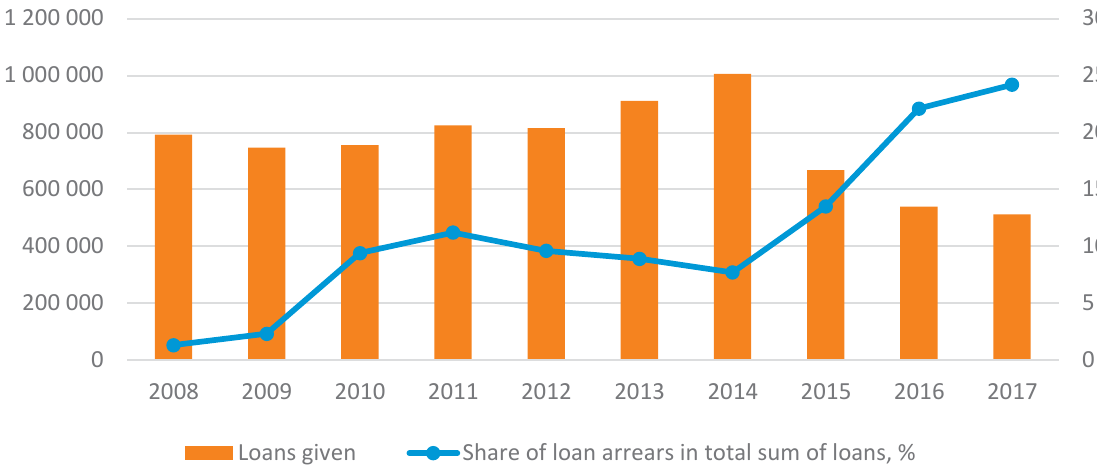
Figure (cid:1006). (cid:24)(cid:455)(cid:374)(cid:258)(cid:373)(cid:349)(cid:272)(cid:400)(cid:3)(cid:381)(cid:296)(cid:3)(cid:367)(cid:381)(cid:258)(cid:374)(cid:400)(cid:3)(cid:336)(cid:349)(cid:448)(cid:286)(cid:374)(cid:3)(cid:271)(cid:455)(cid:3)(cid:104)(cid:364)(cid:396)(cid:258)(cid:349)(cid:374)(cid:349)(cid:258)(cid:374)(cid:3)(cid:271)(cid:258)(cid:374)(cid:364)(cid:400)(cid:3)(cid:258)(cid:374)(cid:282)(cid:3)(cid:400)(cid:346)(cid:258)(cid:396)(cid:286)(cid:3)(cid:381)(cid:296)(cid:3)(cid:367)(cid:381)(cid:258)(cid:374)(cid:3)(cid:258)(cid:396)(cid:396)(cid:286)(cid:258)(cid:396)(cid:400)(cid:3)(cid:3) (cid:296)(cid:381)(cid:396)(cid:3)(cid:410)(cid:346)(cid:286)(cid:3)(cid:393)(cid:286)(cid:396)(cid:349)(cid:381)(cid:282)(cid:3)(cid:1006)(cid:1004)(cid:1004)(cid:1012)(cid:884)(cid:1006)(cid:1004)(cid:1005)(cid:1011)